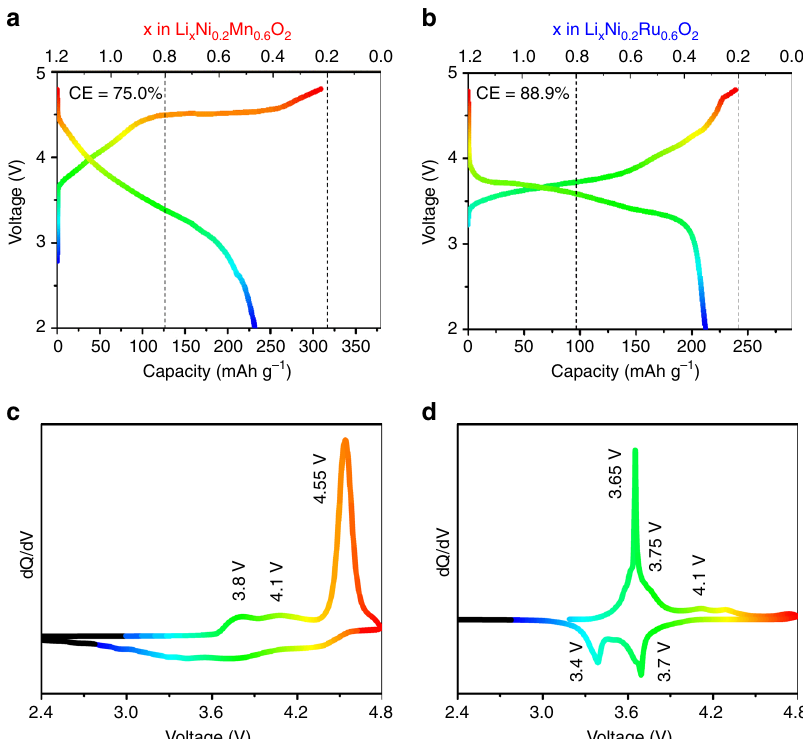
Fig. 2 First charge – discharge characteristics of LNMO and LNRO. The fi rst cycle voltage pro fi le of a LNMO and b LNRO; differential capacity (d Q /d V ) plot of c LNMO and d LNRO. Cells were cycled between 4.8 and 2.0 V at a current density of 5 mA g – 1 at room